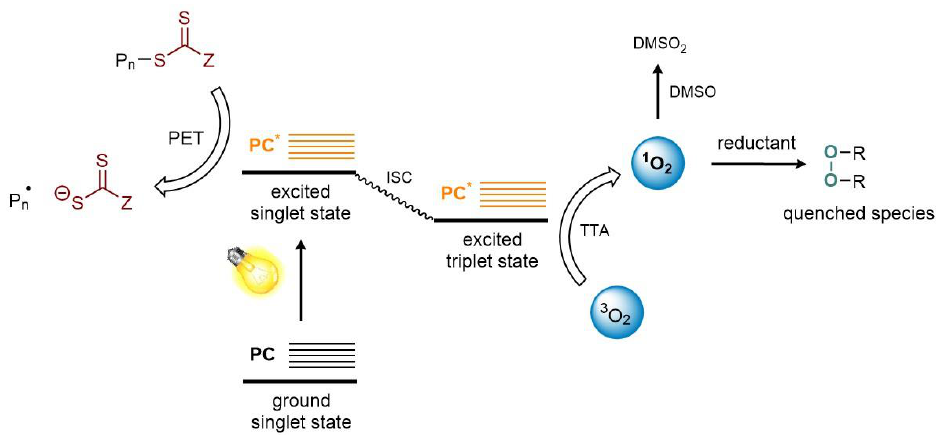
Figure 8. Schematic representation of the photophysic process involved in the intrinsic oxygen tol- erance of PET-RAFT. ISC: intersystem crossing; *: excited state. tolerance of PET-RAFT. ISC: intersystem crossing; *: excited